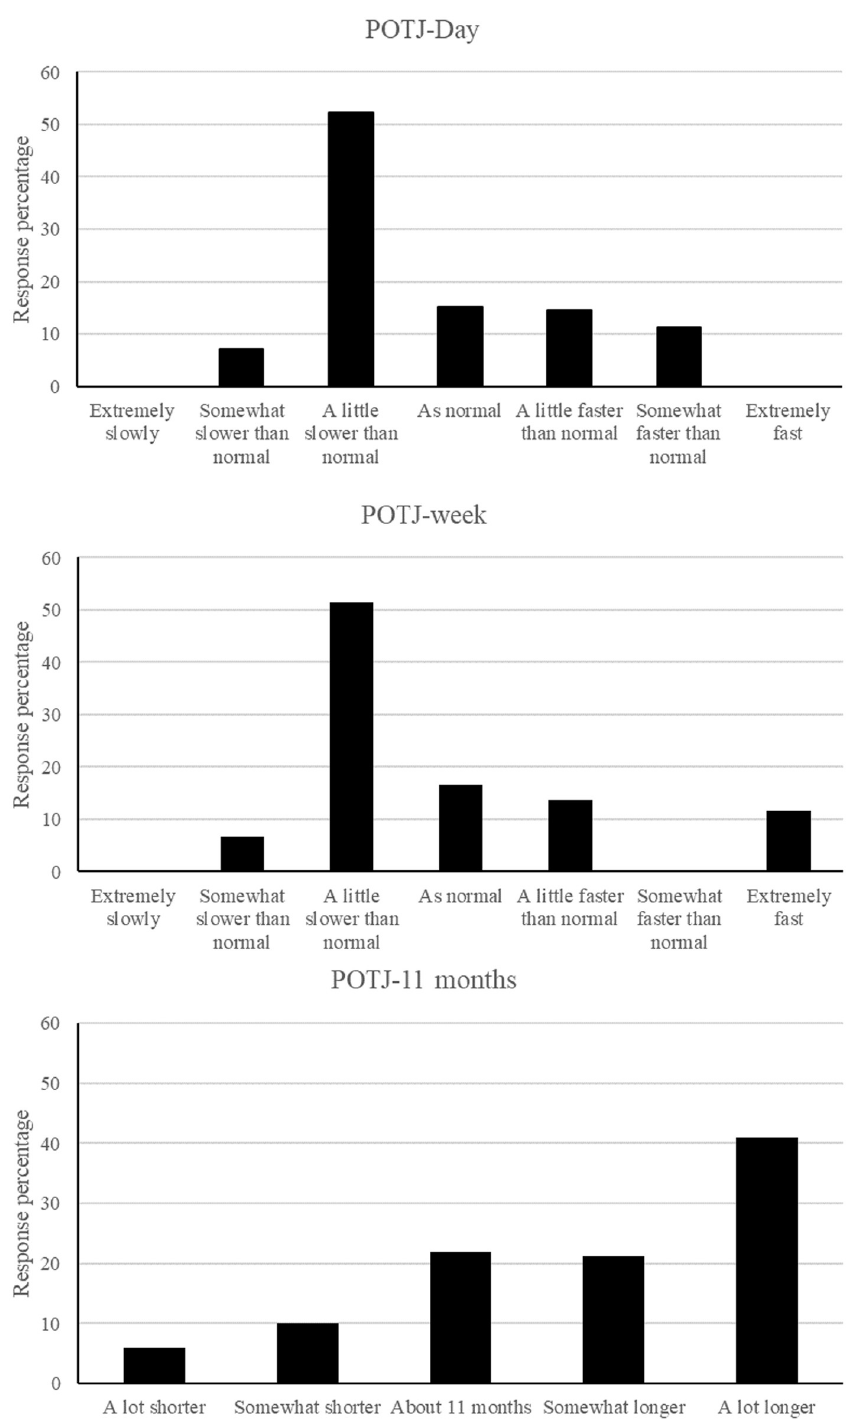
Fig 1. The frequency of responses for each Likert point for the day judgement (upper panel), week judgment (middle panel) and 11-month judgment (lower panel).